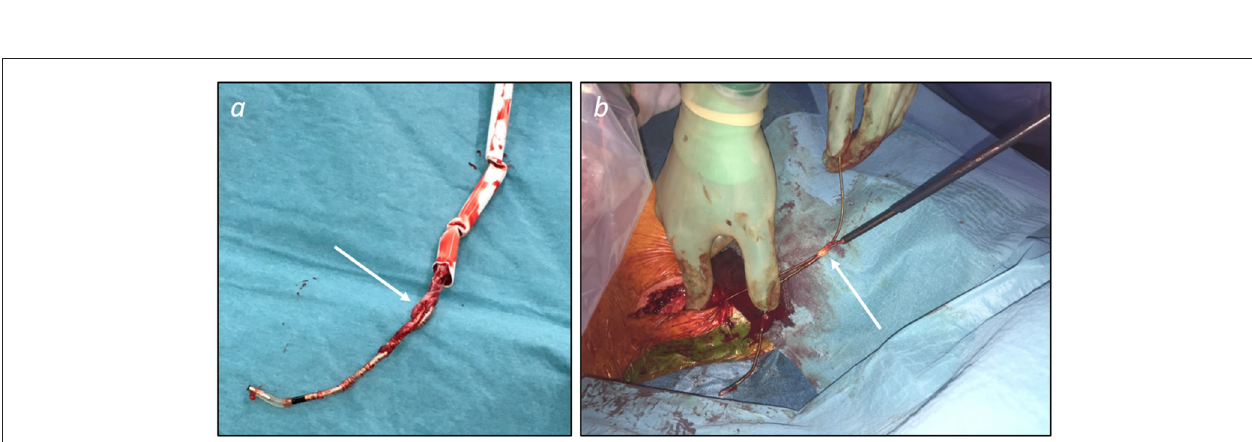
Frontiers in Cardiovascular Medicine | www.frontiersin.org